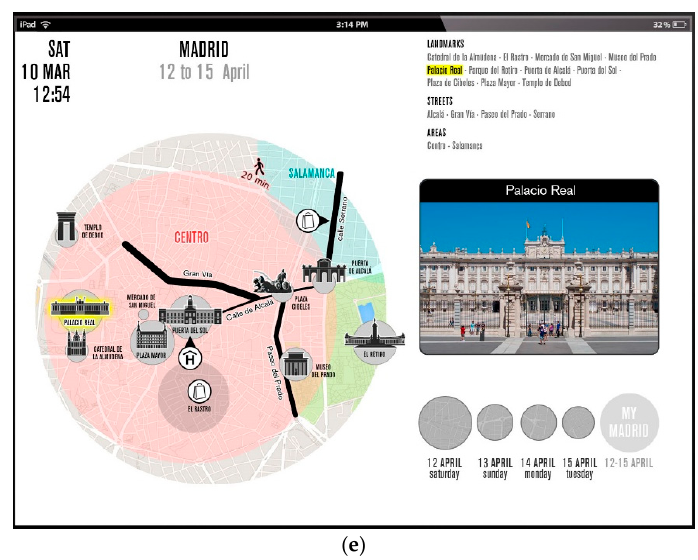
Figure 11. Maps created for tourist T1 (Guided), illustrating the places to visit daily in Madrid. The pink circle shows the POIs reachable within a 20-min walk from the tourist’s accommodation, located in the city’s “Centro” zone. Maps in ( a – d ) take into account the average number of features and the differentiated reference system of the Guided participant’s sketches (cluster of elements organized around a fixed feature, the hotel). The map in ( e ) summarizes the information on the four previous maps in a coordinated reference system, in order to help user T1 to integrate the information of the daily experiences in a single map. During the stay in Madrid, the maps will evolve to distinguish the POIs and streets already visited, from the ones yet to be seen. If tourist T1 takes photos, they will replace the generic images. Places visited instead of or in addition to the initial plan will also be included. ISPRS Int. J. Geo-Inf. 2018 , 7 , x FOR PEER REVIEW